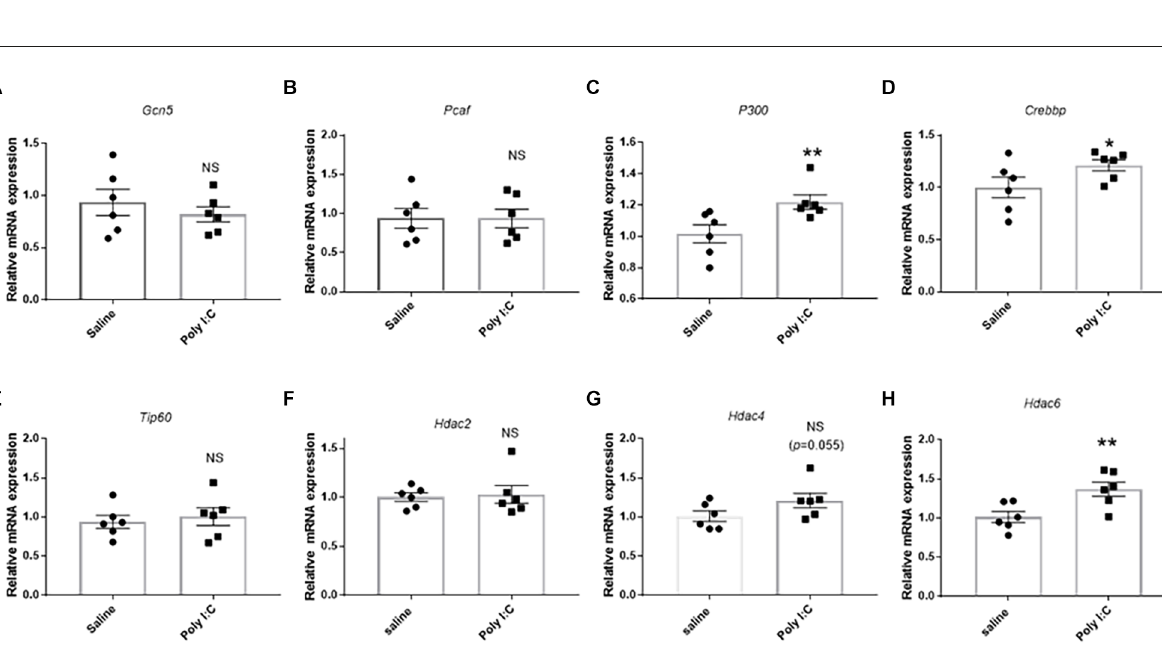
FIGURE4 Effect of prenatal Poly I:C exposure on the mRNA expression of histone acetyltransferases (HATs) and deacetylases (HDACs). (A) Gcn5 , (B) Pcaf , (C) P300 , (D) Crebbp , (E) Tip60 , (F) Hdac2 , (G) Hdac4 , and (H) Hdac6 . Data were presented as mean ± SEM ( n = 6 per group). NS, no significance; * p < 0.05, ** p < 0.01; Poly I:C vs.